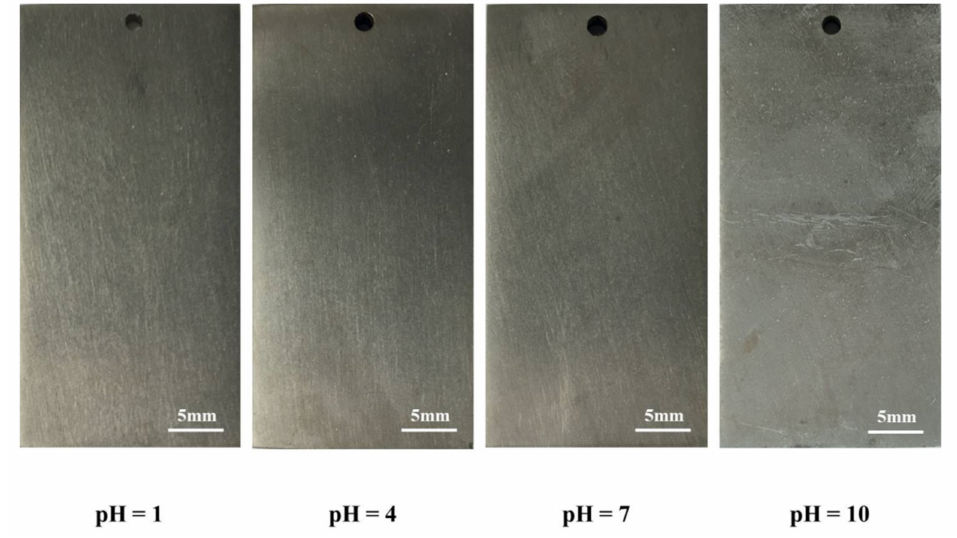
Figure 9. Macroscopic morphology of TA2 in simulated seawater solution with different pH